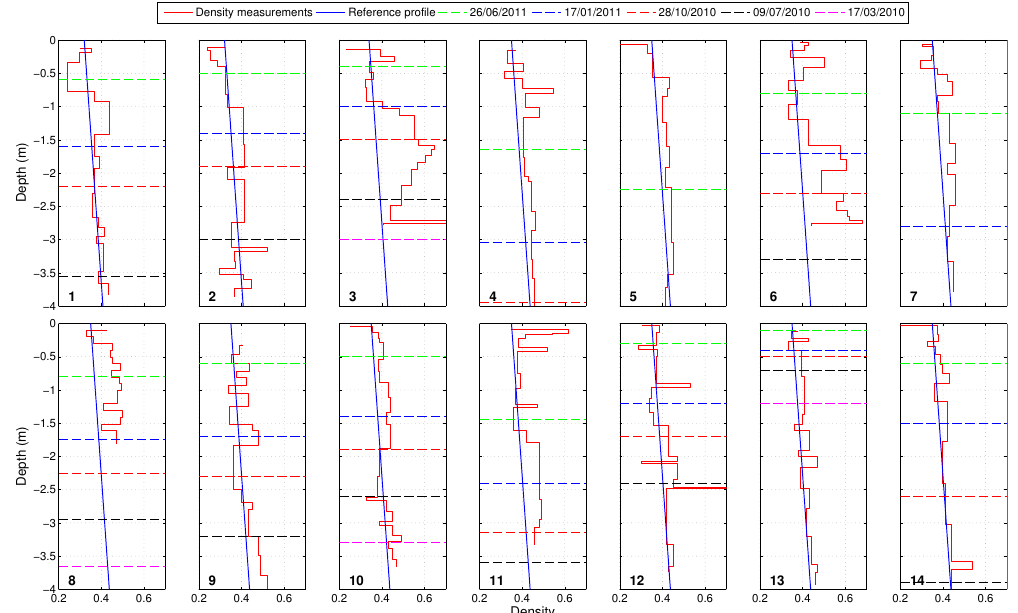
Fig. 9. Density profiles (red line) measured on 27 September 2011. Dashed lines correspond to different surface horizons identified at different dates. Blue lines are reference density profiles determined using the empirical model proposed by Herron and Langway